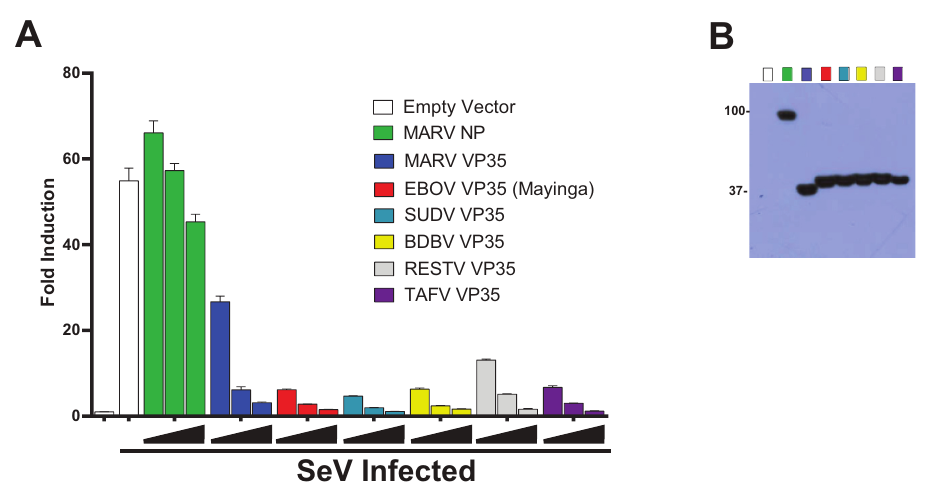
Fig 1. VP35 proteins from Marburg virus and all five Ebolavirus species antagonize SeV induced promoter activity. The abilitiesof the VP35 proteins from Marburgvirus and the five speciesof Ebolavirusto antagonize the IFN responseinducedby virus infectionwere comparedin the context of a luciferase reporter under the control of the IFN- β promoter. (A) 293T cells were transfected with increasing amounts (4 ng, 20 ng, or 100 ng) of pCAGGS-basedplasmidsexpressingN-terminally FLAG-tagged filoviral proteins, an empty pCAGGS plasmidto transfect equal amountsbetweensamples, and a plasmidexpressingRenillaluciferase as a transfectioncontrol. The followingday, cells were either mock-infected or infected with SeV to induce IFN- β promoteractivity. The third day, cells were harvestedand luciferaseexpressionwas measured.Error bars represent standard error of the mean of triplicates. MARV, Marburg Virus; EBOV, Ebola Virus (Mayinga); SUDV, Sudan Virus; BDBV, Bundibugyo Virus; RESTV, Reston Virus; TAFV, Ta ï Forest Virus. (B) Western blot analysisagainstthe FLAG tag shows relative expressionof filoviral proteinswhen 100 ng of each FLAG- taggedprotein-expressing plasmidwas transfected.